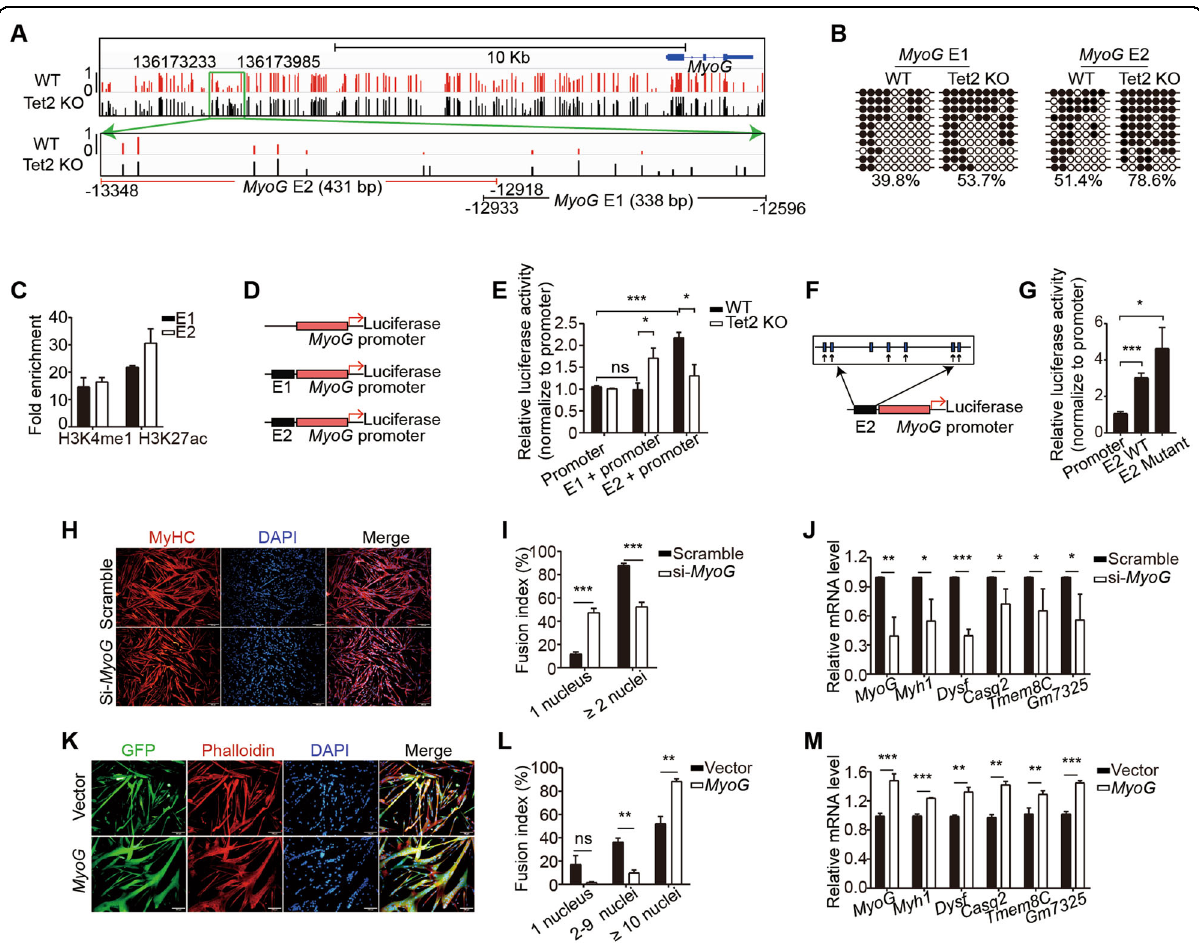
Fig. 5 Tet2 targets MyoG to facilitate muscle regeneration. A Methylation pro fi le of the 5 ’ upstream region of MyoG gene in WT or Tet2 KO myoblasts extracted from genome-wide methylation-seq. B Bisul fi te sequencing results of E1 and E2 enhancers of MyoG . C H3K4me1 and H3K27ac levels in E1 and E2 enhancer regions of MyoG ( n = 3). D Scheme of the luciferase reporter constructs. E Luciferase activity of the E1 or E2 enhancer ( n = 3). F Scheme of the mutated luciferase reporter constructs. Black arrows indicated the mutated CpG sites. G Luciferase activity of the E2 enhancer mutant ( n = 3). H Immuno fl uorescence staining of MyHC in MyoG knocked down myotubes. Scale bars, 200 µm. I Quanti fi cation of the fusion index in MyoG knocked down myotubes (n = 3). J Relative mRNA expression levels of differentiation related genes in MyoG knocked down myotubes ( n = 3). K Immuno fl uorescence staining of GFP and Phalloidin in MyoG over-expressing myotubes. Scale bars, 100 µm. L Quanti fi cation of the fusion index in MyoG over-expressing myotubes ( n = 3). M Relative mRNA expression levels of differentiation related genes in MyoG over-expressing myotubes ( n = 3). * p < 0.05, ** p < 0.01, *** p <